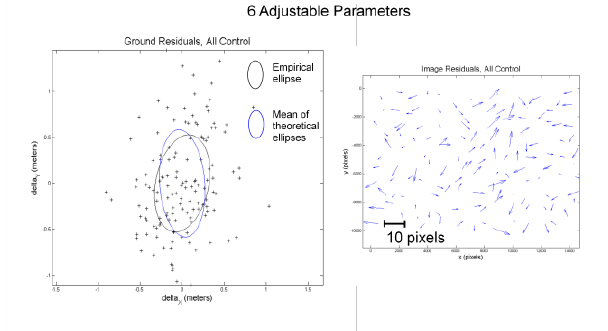
Figure 11. Ground and image coordinate residuals after resection with 6 adjustable